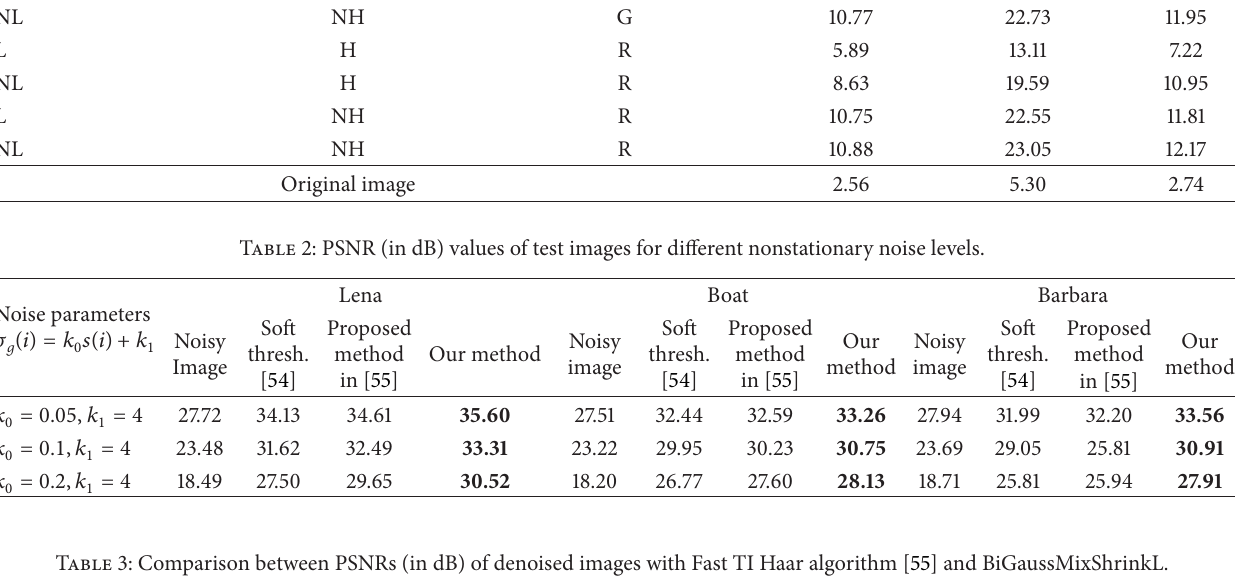
Table 3: Comparison between PSNRs (in dB) of denoised images with Fast TI Haar algorithm [55] and BiGaussMixShrinkL. Lena Boat